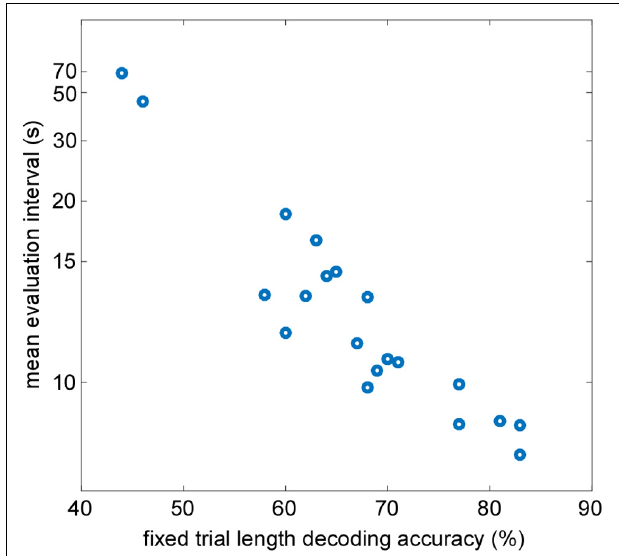
FIGURE 4 | Correlation between individual mean evaluation intervals determined by the staircase procedure and attended speaker decoding accuracy calculated at fixed evaluation intervals of 30 s (r_Pearson = -0.93, p <